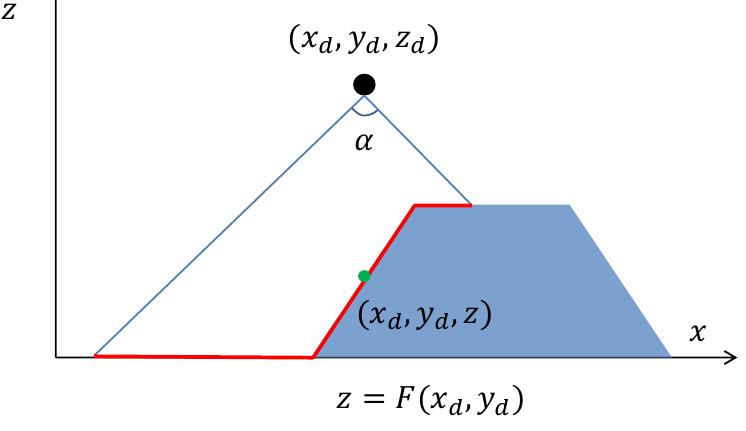
Figure 1. The region a drone can